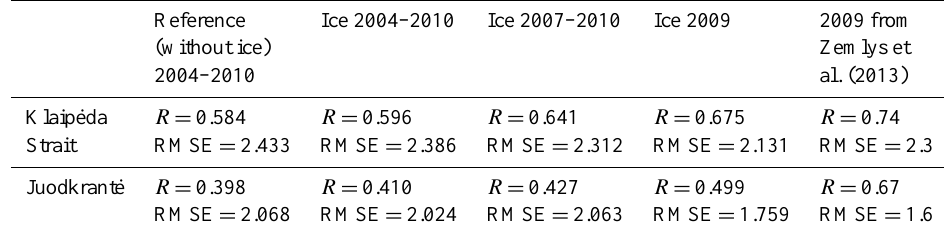
Table 2. Model validation results for salinity. Given are correlation coefficients and root mean square error in ‰. The results refer to the reference simulation, the simulation with ice cover (10 years), only the 4 years where ice cover was available, only 2009 with ice cover, and results from the article Zemlys et al.